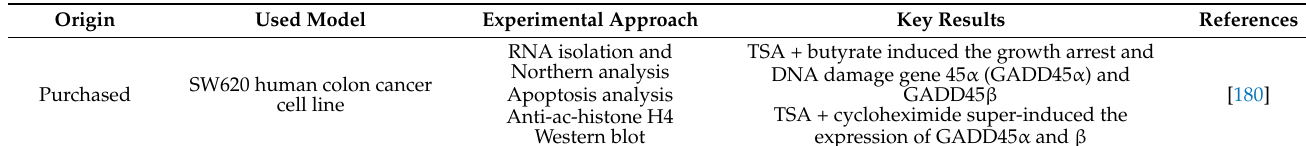
Table 6. Synergistic anticancer activity of